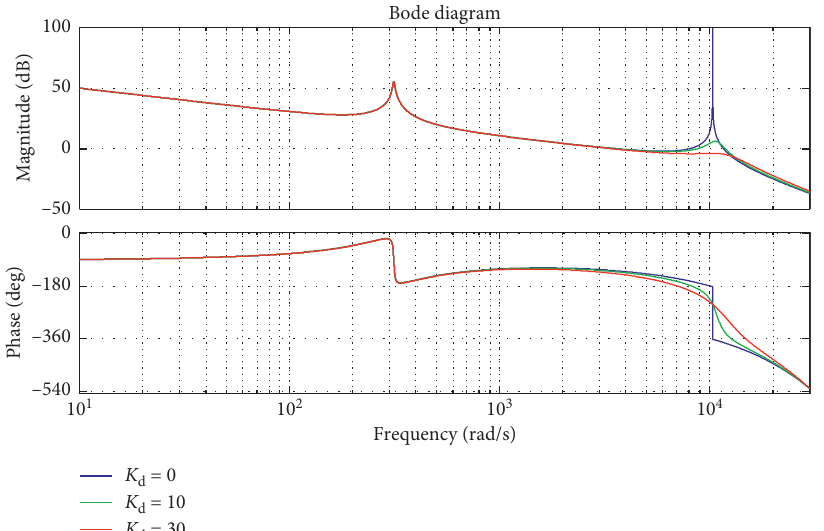
Figure 8: Bode plot of the open loop for different damping gains K